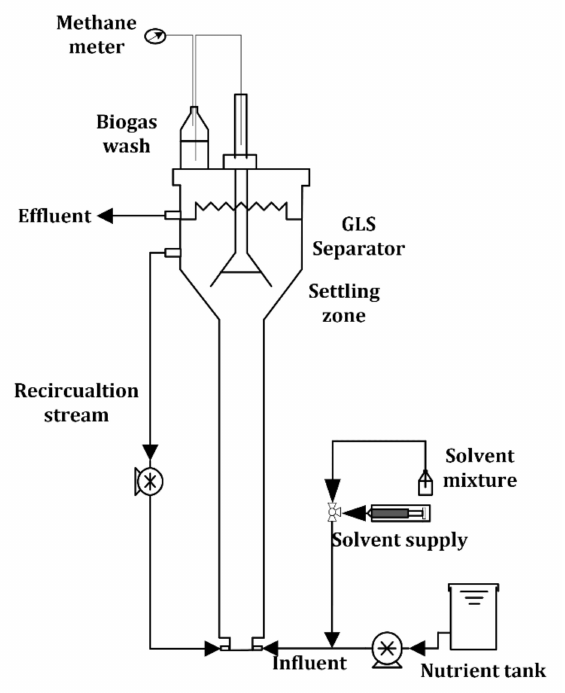
Figure 1. Scheme of the experimental